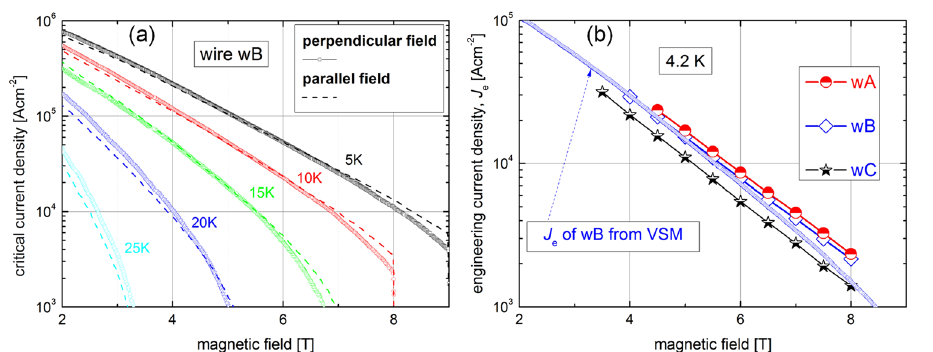
Figure 3. Critical current densities of the wB wire obtained from the VSM measurement ( a ) and J e ( B ) from the transport DC measurement of wires wA, wB and wC at 4.2 K ( b ) including J e of wB wire from VSM